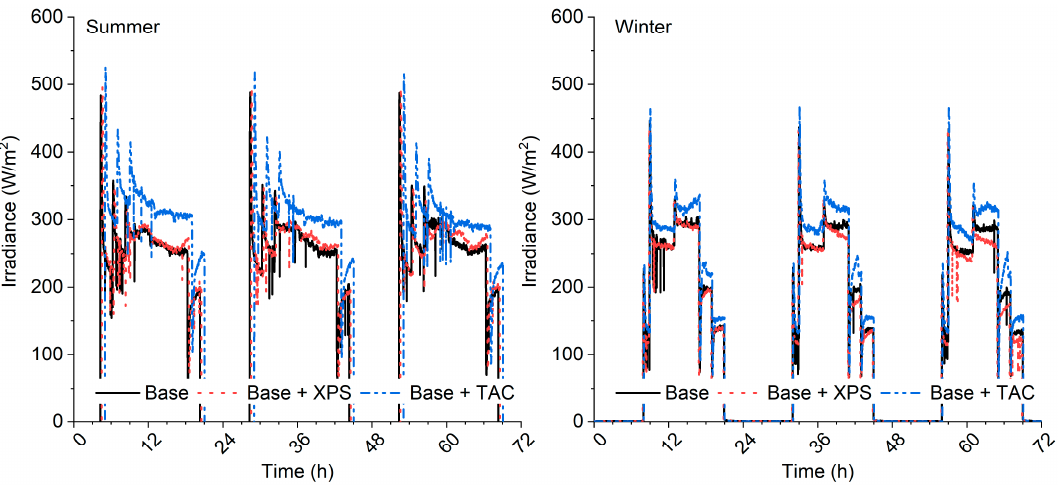
Figure 8. IR irradiance on the exterior wall surfaces.